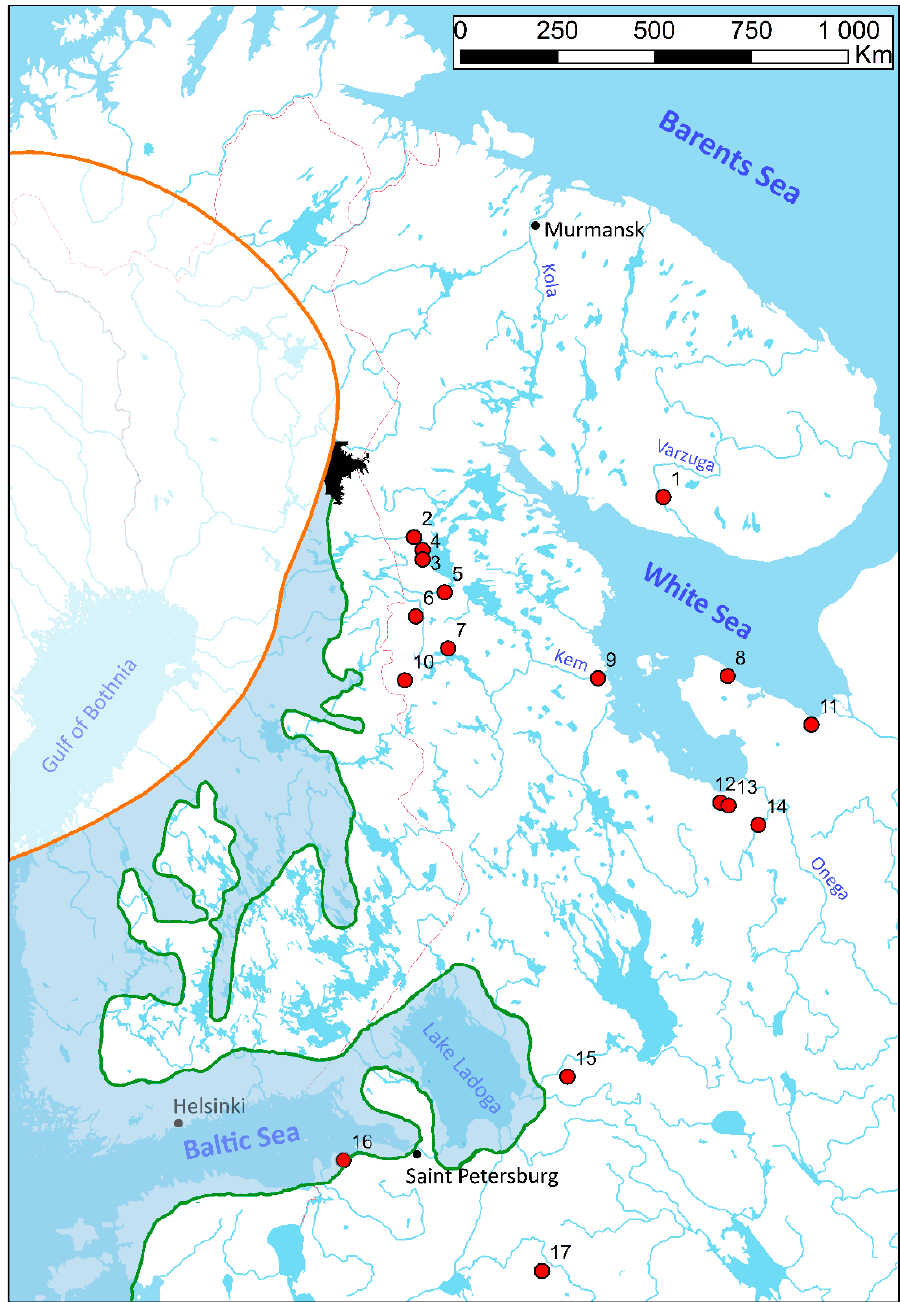
Figure 2. Map of sampling locations of the Margaritifera margaritifera populations used for analysis at the regional scale with paleogeographic reconstructions showing: orange line—the glacier margin position at 10.5 Kyr BP ([37]: Figure 9), green line—the Ancylus Lake during the maximum transgression at 10.5 Kyr BP ([38]: Figure 4.7), black filling—area occupied by the Salla Ice Lake immediately before the rapid lowering of the water level and draining to the Ancylus Lake ([39]: Figure 36). Sampling location numbers correspond to the population numbers in Table 1. The map was created using ESRI ArcGIS 10 software (Environmental Systems Research Institute, Redlands, CA, USA); the topographic base of the map was created with Natural Earth Free Vector and Raster Map Data (https://www.naturalearthdata.com, accessed on 9 May 2022); the graphics were drawn using Adobe Photoshop 2022 (Adobe Inc., San Jose, CA,